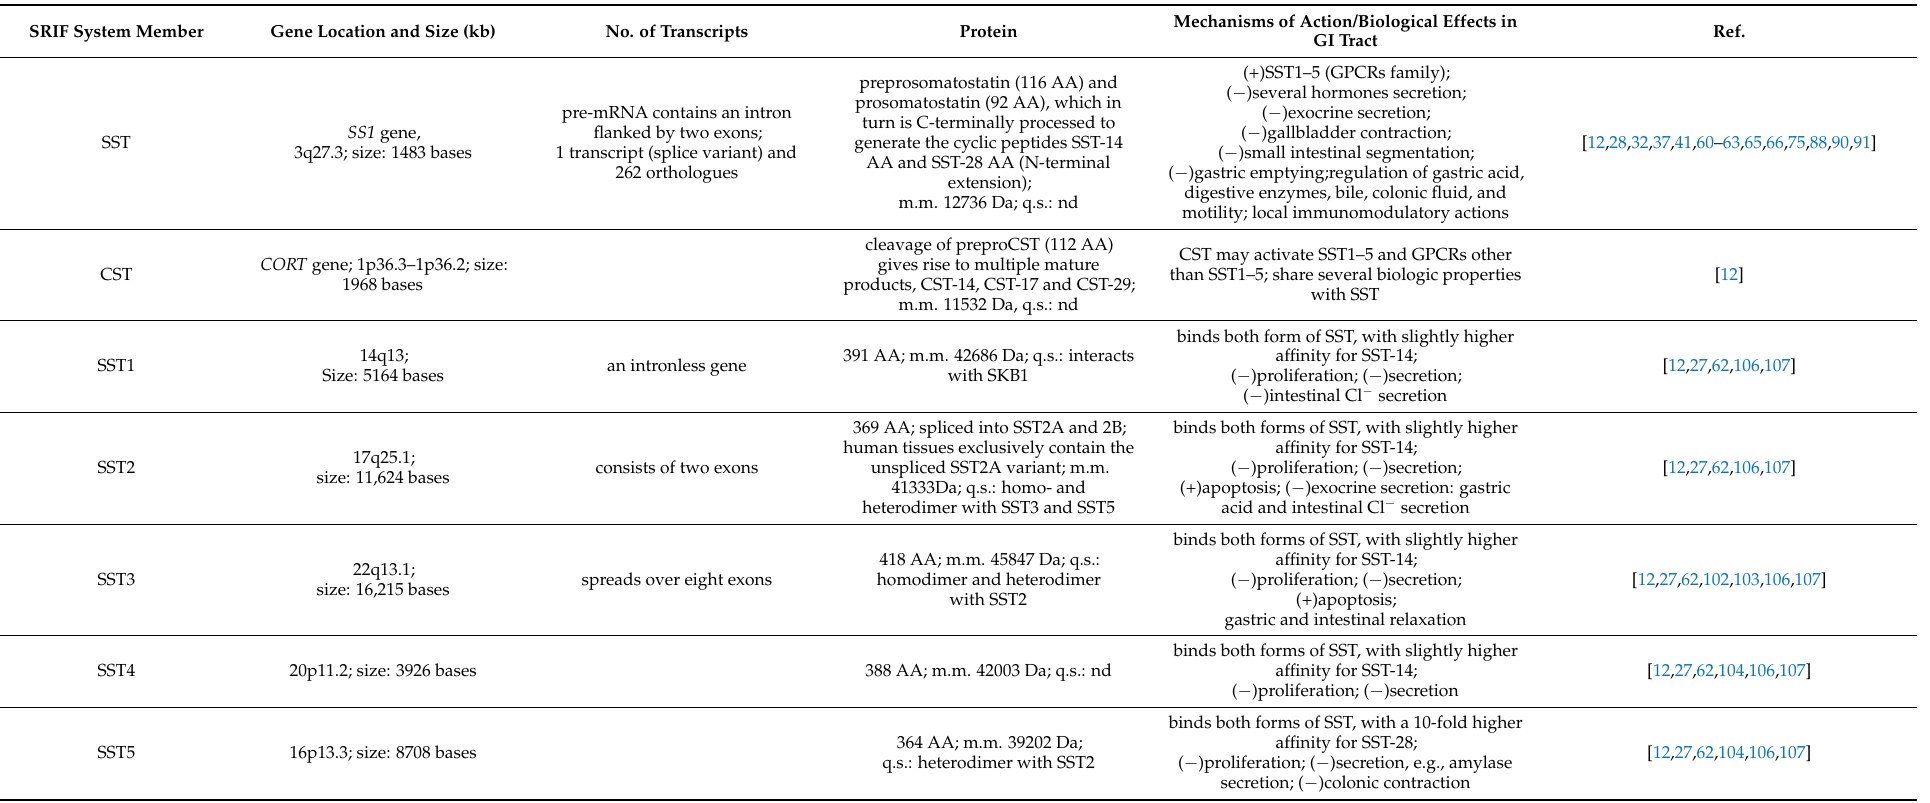
Table 1. Molecular characteristics of the human SRIF system components and the major biological effects in the gastrointestinal (GI)